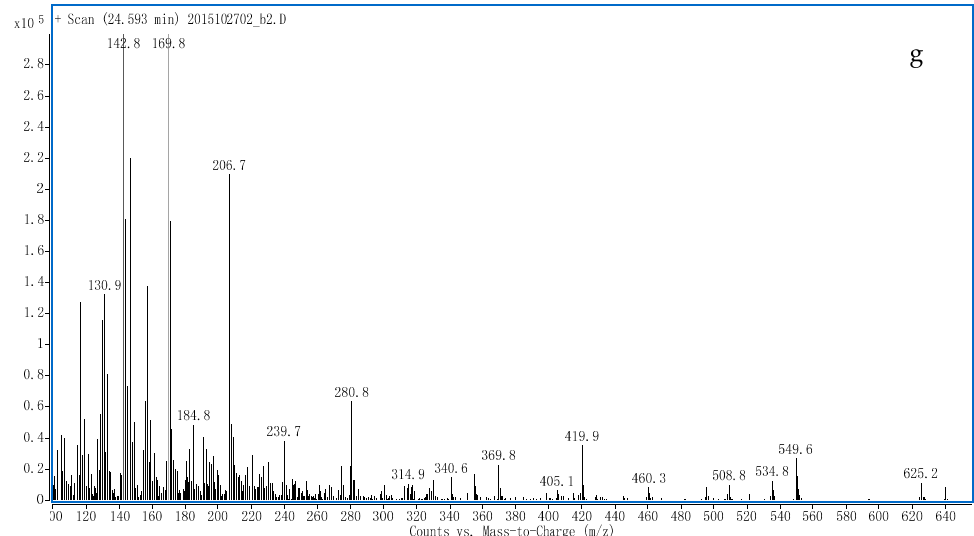
Figure 4. The electron ionization mass spectra of TMS derivatives of the phase II metabolites of: G1 ( a ); G2 ( b ); G3 ( c ); G4 ( d ); G5 ( e ); G6 ( f ); and G7 ( g ) released after hydrolysis.